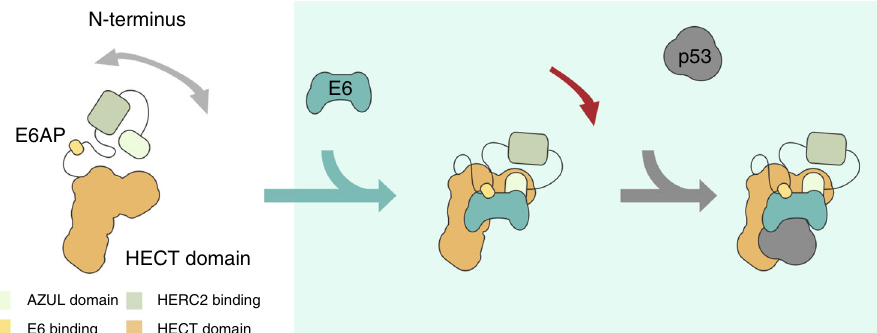
Fig. 5 Model of E6-mediated ubiquitylation of p53. Model of E6-mediated ubiquitylation of p53 in the E6AP – E6 – p53 enzyme – substrate complex. Upon binding, E6 induces a conformational rearrangement in E6AP that brings the AZUL domain closer to the HECT domain. This leads to the concomitant positioning of E6 and the substrate p53 into the direct vicinity of the catalytic center of E6AP within the enzyme – substrate complex. There, E6 now functions as an adaptor facilitating the direct transfer of ubiquitin from the HECT domain of E6AP to